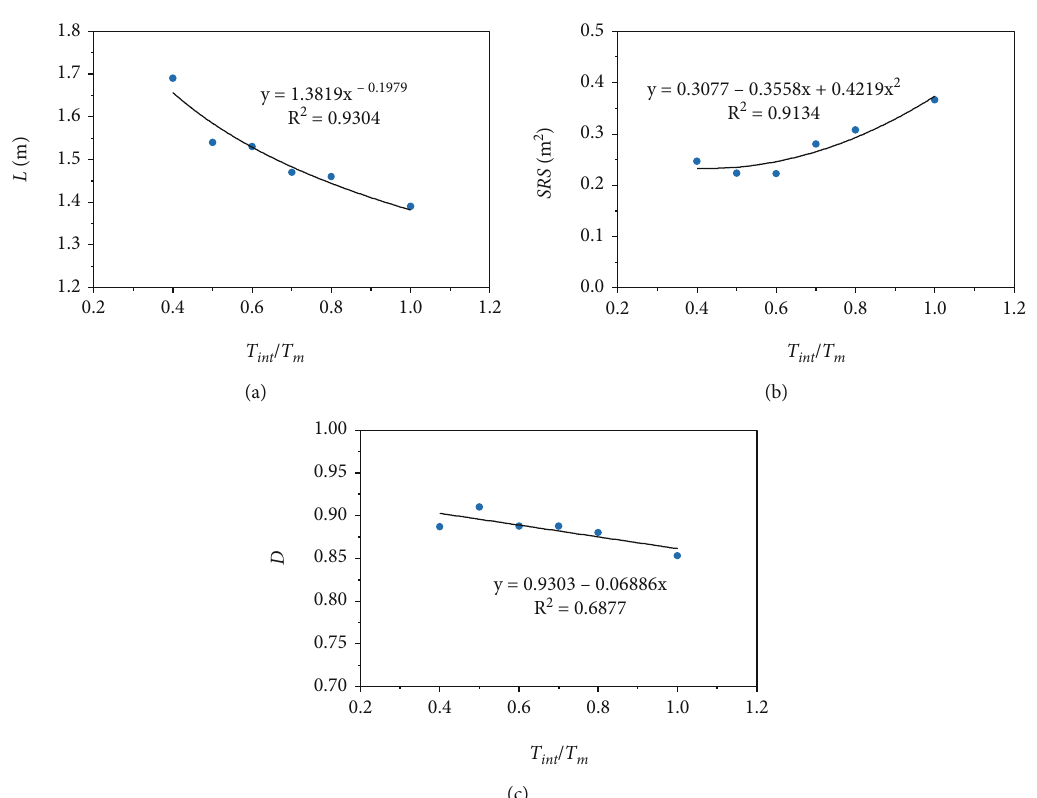
Figure 16: Geometric parameters of HF under di ff erent ratios of matrix-gravel interface tensile strength to